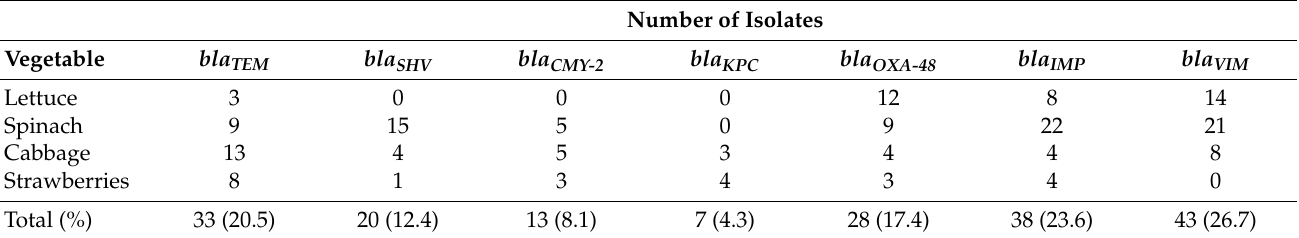
Table 4. Frequency of ARG detection in the isolates. Number of